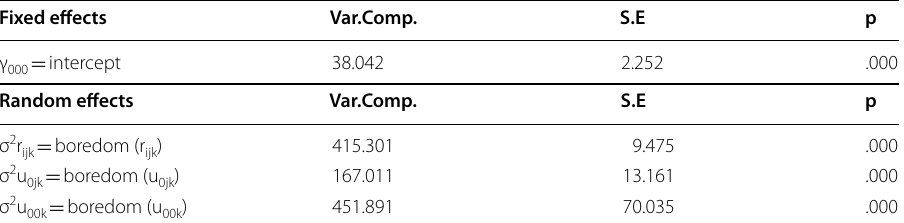
Table 2 Intraclass-correlations (ICC) of students’ boredom at the level of lessons and measurement time